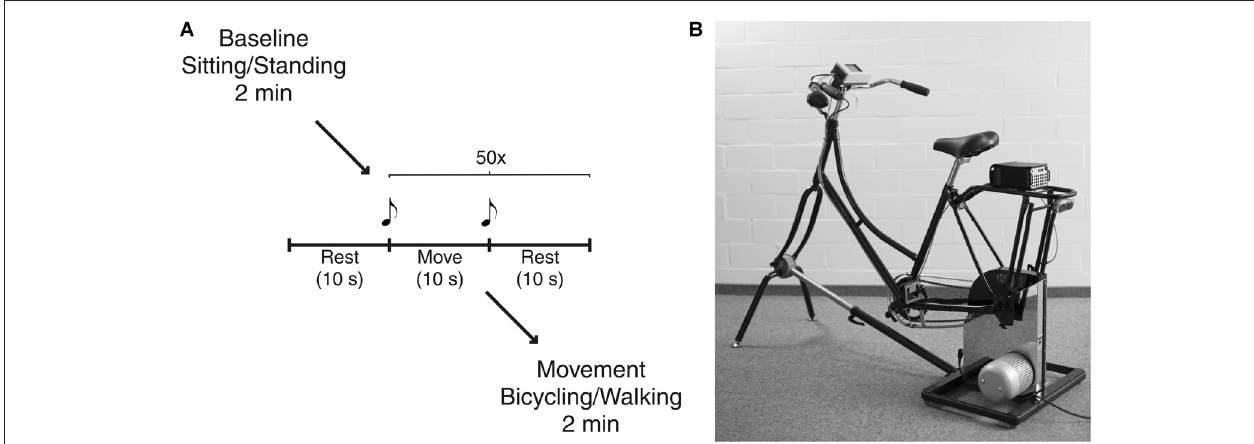
FIGURE 1 | Experimental setup. (A) Schematic illustration of the experimental paradigm. Each condition started with a baseline rest period of 2 min, i.e., sitting on the bicycle or standing, respectively. After further 10 s of rest participants performed an alternating sequence containing 10 s of movement, i.e., bicycling or walking, and 10 s of rest. This was repeated 50 times. Start and end of the movement phase were indicated by an acoustic signal. Finally, participants engaged in continuous movement for 2 min. (B) The bicycle simulator compromises a Dutch-style bicycle frame mounted on an ergometer. Custom-made software electronics and optical sensors tracked pedal position that was recorded simultaneously with all electrophysiological